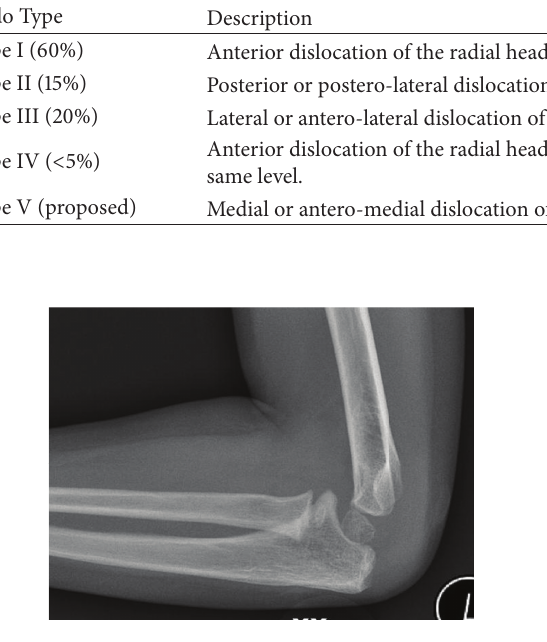
Figure 5: Lateral radiograph four months postoperatively. Note the union of the olecranon fracture and the satisfactory position of the radiocapitellar joint.